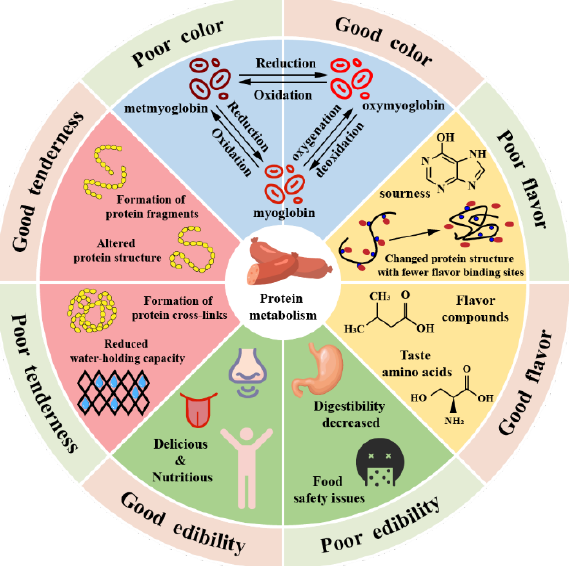
Figure 2. Effects of Protein Changes on the Quality of Fermented Meat